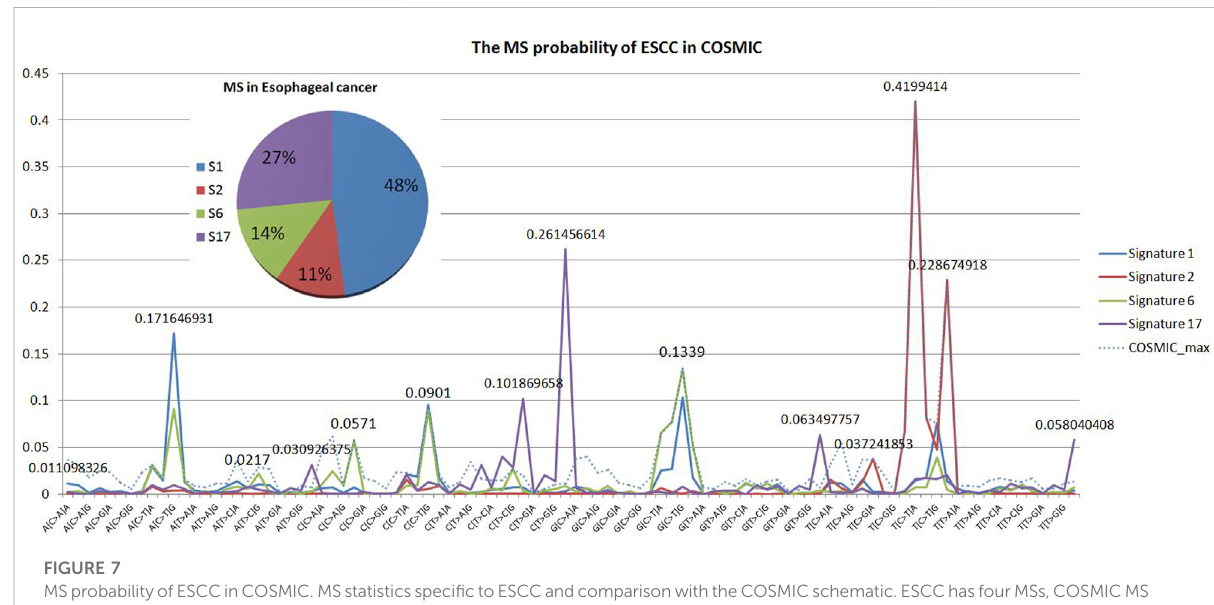
FIGURE 7 MSprobabilityofESCCinCOSMIC.MSstatisticsspeci fi ctoESCCandcomparisonwiththeCOSMICschematic.ESCChasfourMSs,COSMICMS 1,2, 6,and17, accounting for theprobabilitystatisticsofthe96tri-nucleotide structureresultsofMS1,2,6, and17,as showninthepie.Cosmic_max indicates the maximum value of the cosmic library records corresponding to the 96 tri-nucleotide results.